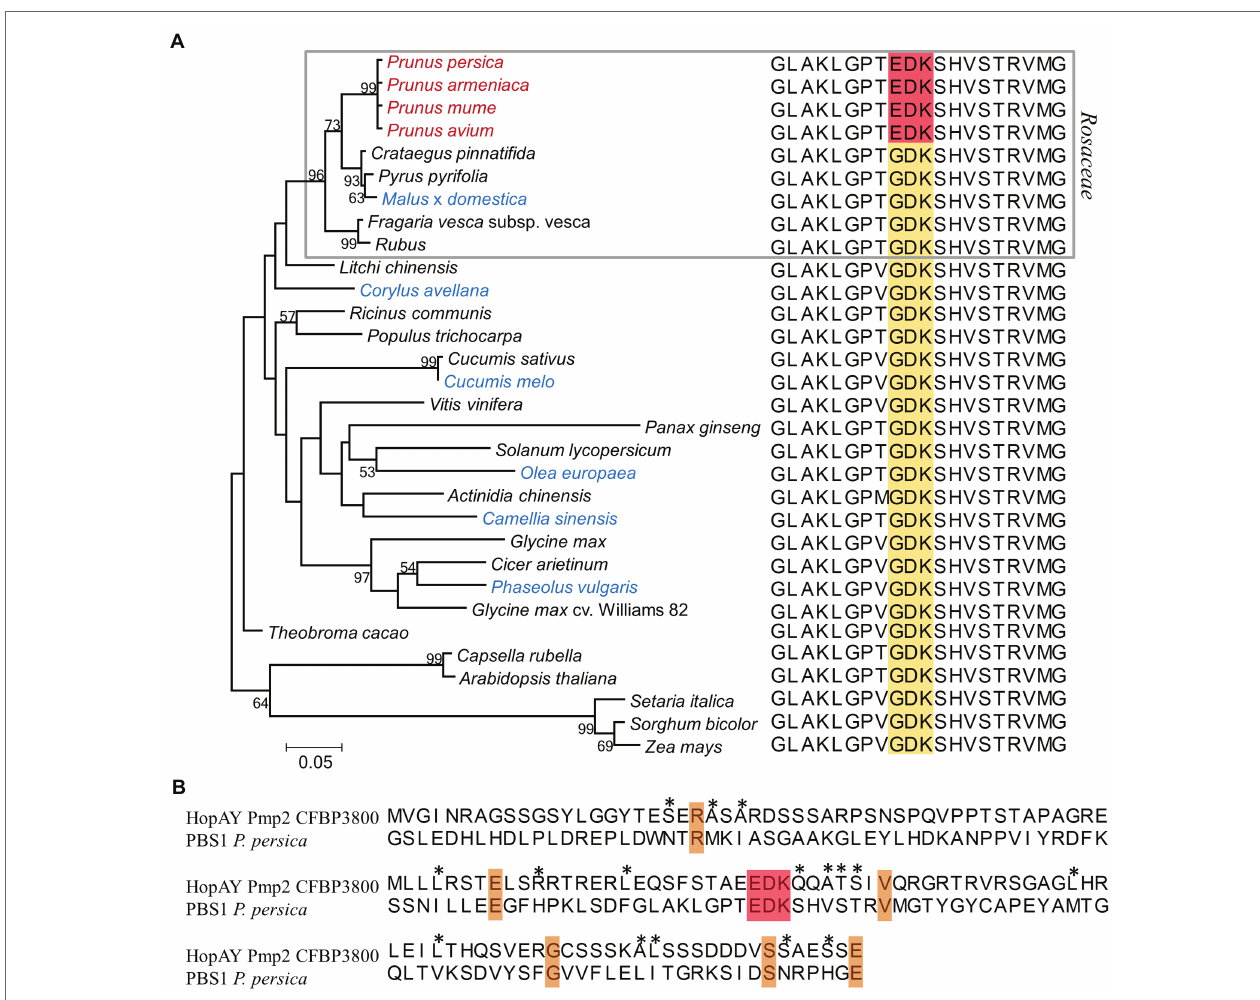
FIGURE 3 | Comparison of the serine/threonine protein kinase PBS1 among different plant species (A) and relation to the HopAY sequence (B) . (A) Maximum likelihood phylogeny of the PBS1 protein among different plant species and relative PBS1 sequence stretch corresponding to the amino acids 233–252 of the Arabidopsis thaliana PBS1 sequence (NCBI Acc. Nr. NP_196820) containing the HopAR1 cleavage site GDK (brown block). The corresponding EDK region in the PBS1 sequence of the Prunus spp. is highlighted in red. In the phylogeny Prunus spp. members are reported in red, whereas plants other than Prunus spp. from which Pseudomonas syringae strains possessing the HopAY gene were isolated are indicated in blue. The gray block indicates species belonging to the Rosaceae family. The evolutionary distances were computed using the Jones–Taylor–Thornton model matrix-based with a gamma distribution (shape parameter = 2.25). Percent bootstrap (bt) support values calculated for 1,000 reiterations are indicated near node. Only bt values over 51 are displayed. All ambiguous positions were removed for each sequence pair giving a total of 598 positions. Alignments were obtained using ClustalW and phylogenetic analysis was performed with MEGA 6.0. (B) Alignment of HopAY and PBS1 around the EDK region. The first 133 amino acids (aa) of the HopAY sequence of Pseudomonas syringae pv. morsprunorum race 2 CFBP 3800 (Pmp2 CFBP3800) were aligned to the aa 170–302 of the Prunus persica PBS1 sequence (NCBI Acc. Nr. XP_007225732). The EDK motif is highlighted in red, identical residues are highlighted in orange, whereas residues sharing similar side chain properties at a specific position are indicated by